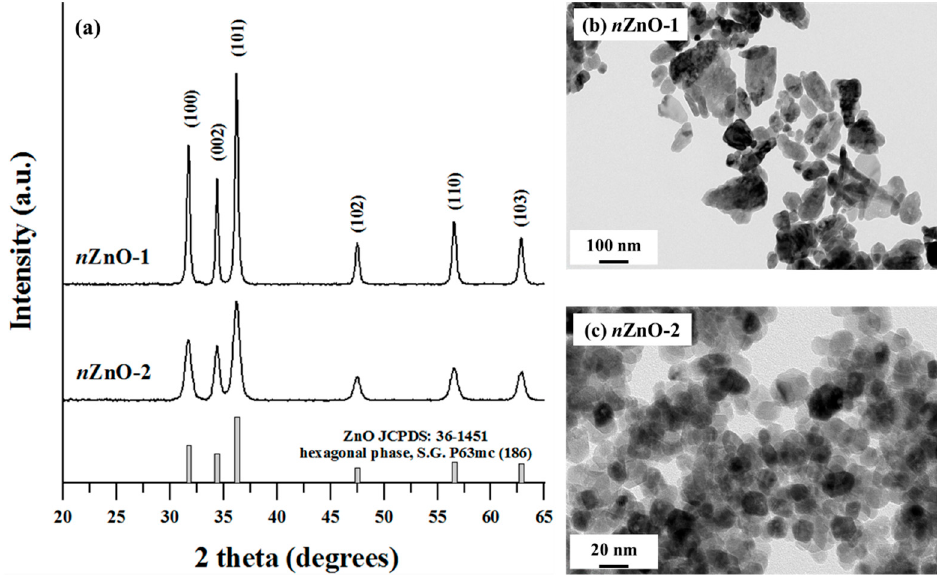
Figure 1. ( a ) XRD patterns of the synthesized n ZnO obtained from synthesis 1 of n ZnO-1 and synthesis 2 of n ZnO-2. TEM images of the synthesized n ZnO obtained from synthesis 1 ( b ) n ZnO-1 and synthesis 2 ( c ) n ZnO-2.